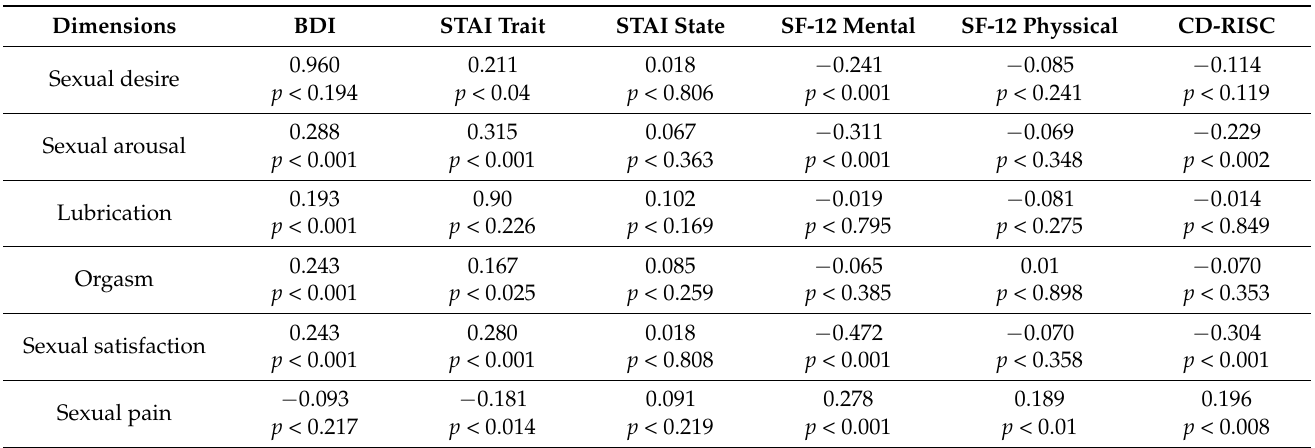
Table 5. Correlation indexes for FSFI domains and other scales. Pearson’s correlation coefficients. Significance level p < 0.05. NS, not significant.